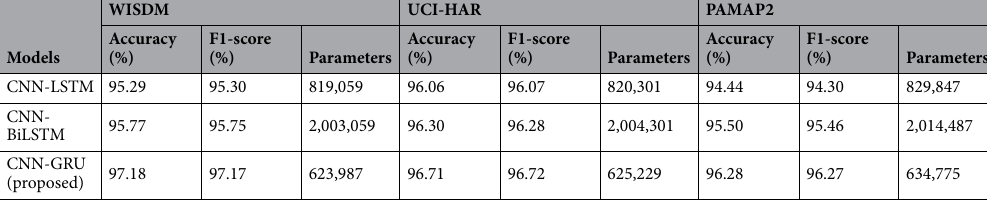
Table 12. Performance comparison of the proposed model with hybrid models with other RNN variants.